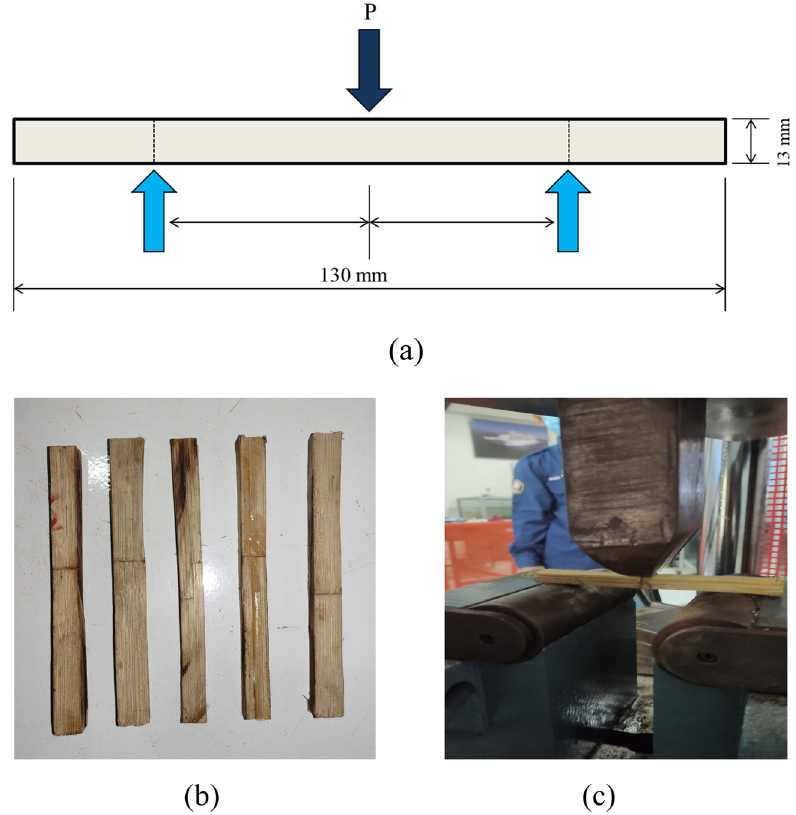
Figure 7: ( a ) Bending test specimen standards according to ASTM D - 7264, ( b ) bending test specimens, and ( c ) specimen testing on the WEW - 1000B